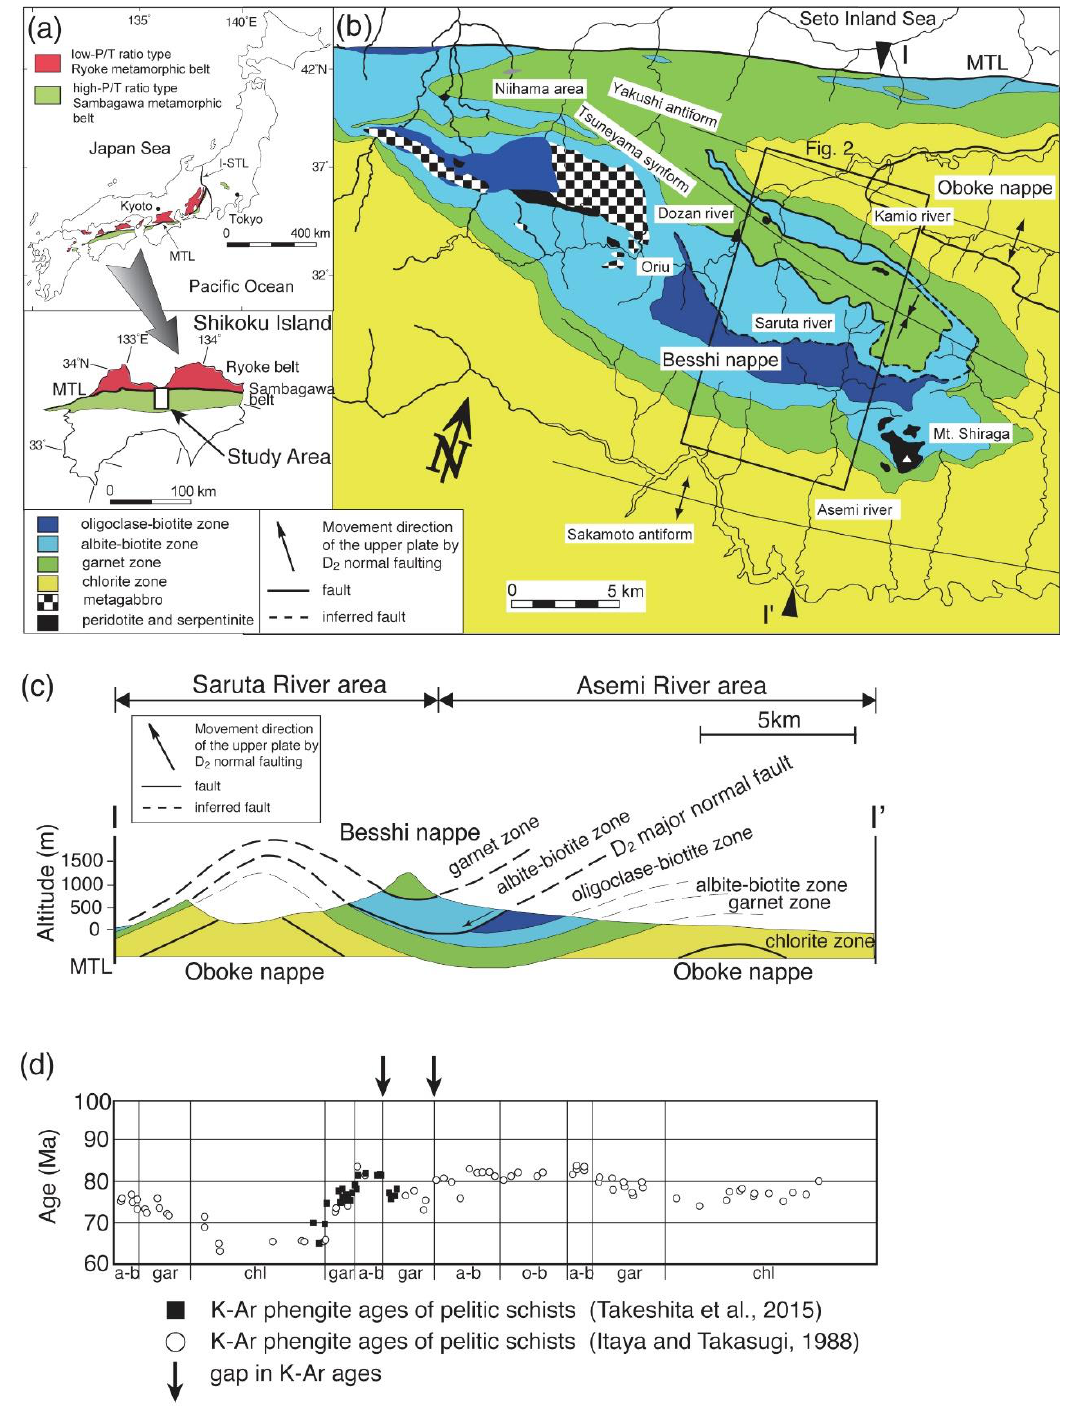
Figure 1. ( a ) Simplified index map of SW Japan and Shikoku Island. ( b ) Metamorphic zonal map of the Sambagawa metamorphic belt, central Shikoku (study area) after [32]. ( c ) Cross-section across central Shikoku (Kamio-Asemi River section). Modified after [29,33,34]. ( d ) Phengite and amphibole K-Ar and 40 Ar/ 39 Ar ages along the Kamio-Asemi River Traverse after [28,29]. The traverse line (I-I’) of ( c ) cross-section and ( d ) age distribution is shown in ( b ). MTL, Median Tectonic Line; I-STL. Itoigawa-Shizuoka Tectonic Line.